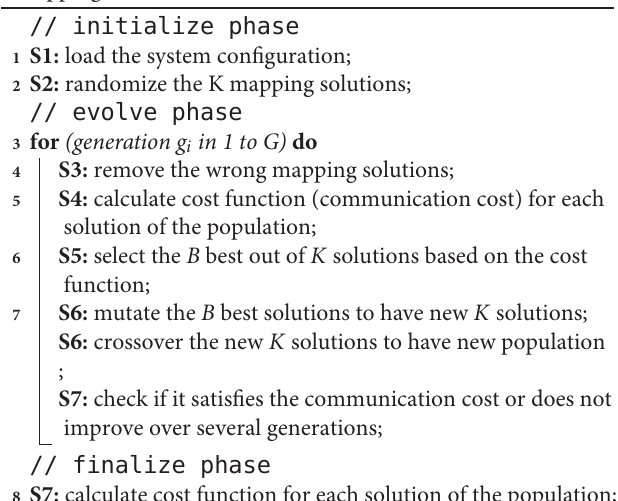
Algorithm 1: Proposed Genetic Algorithm for Neurons Mapping